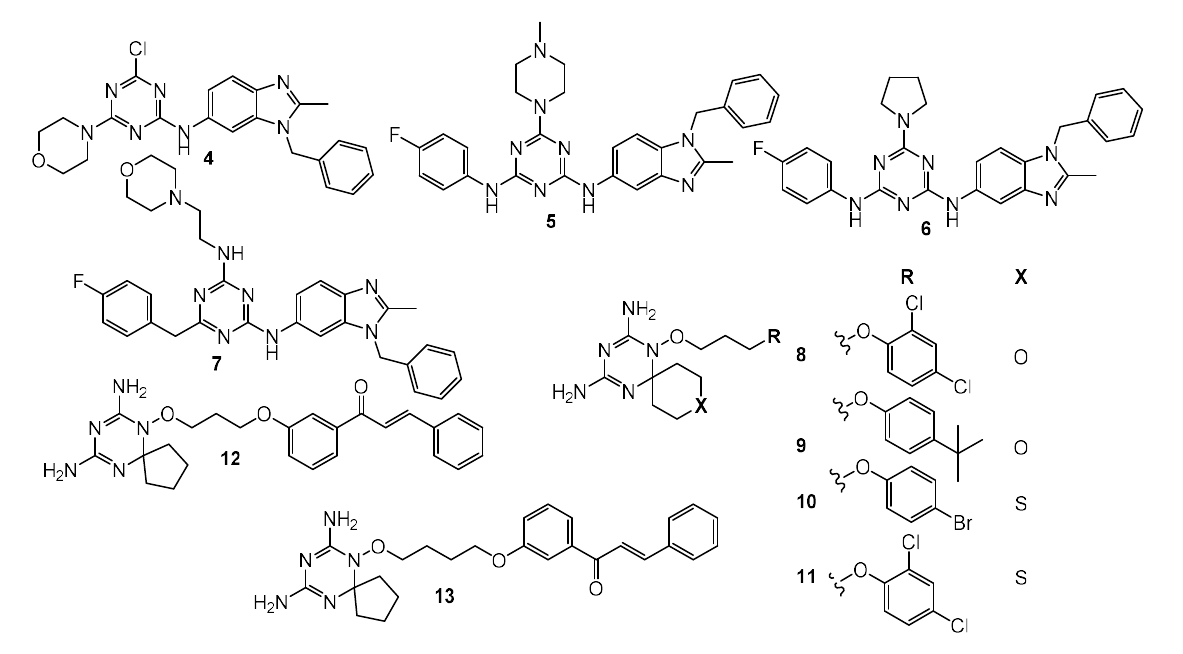
Figure 3. Structure of DHFR inhibitors.